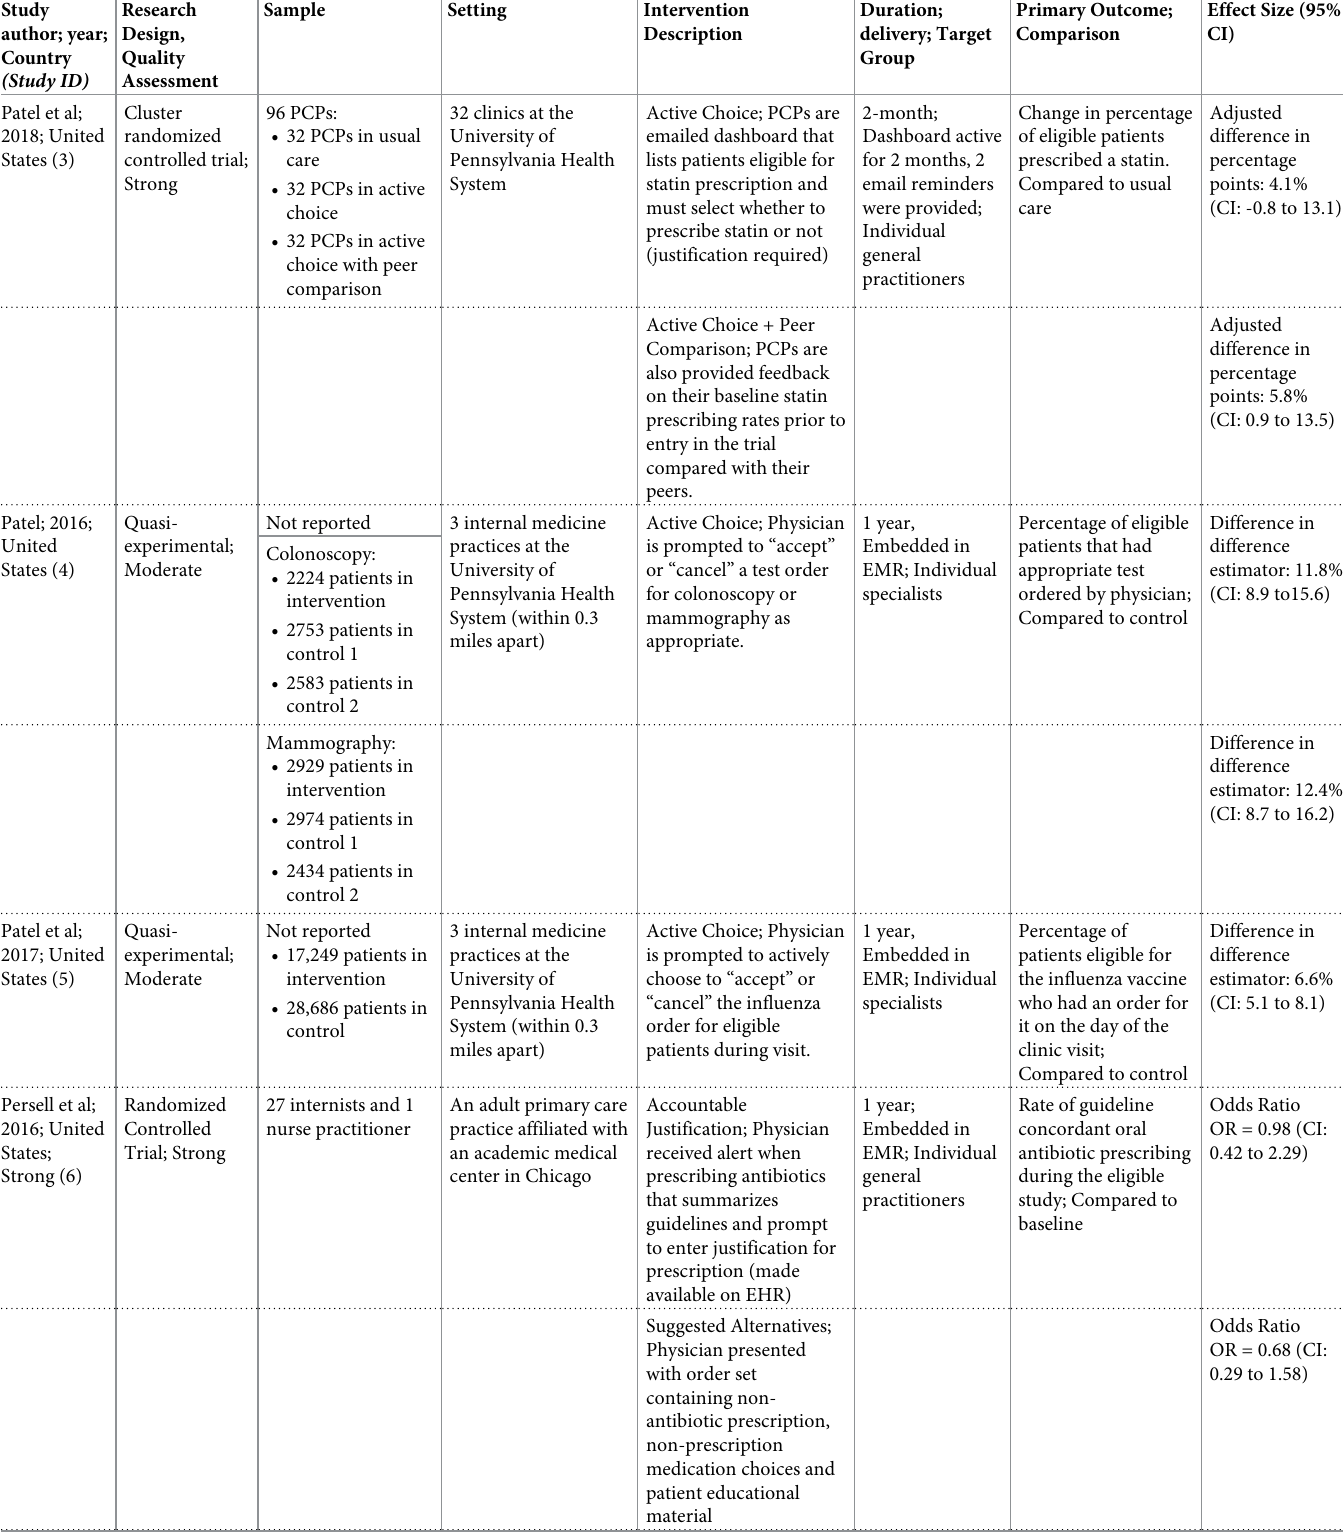
Table 5. Characteristics of included studies (n =